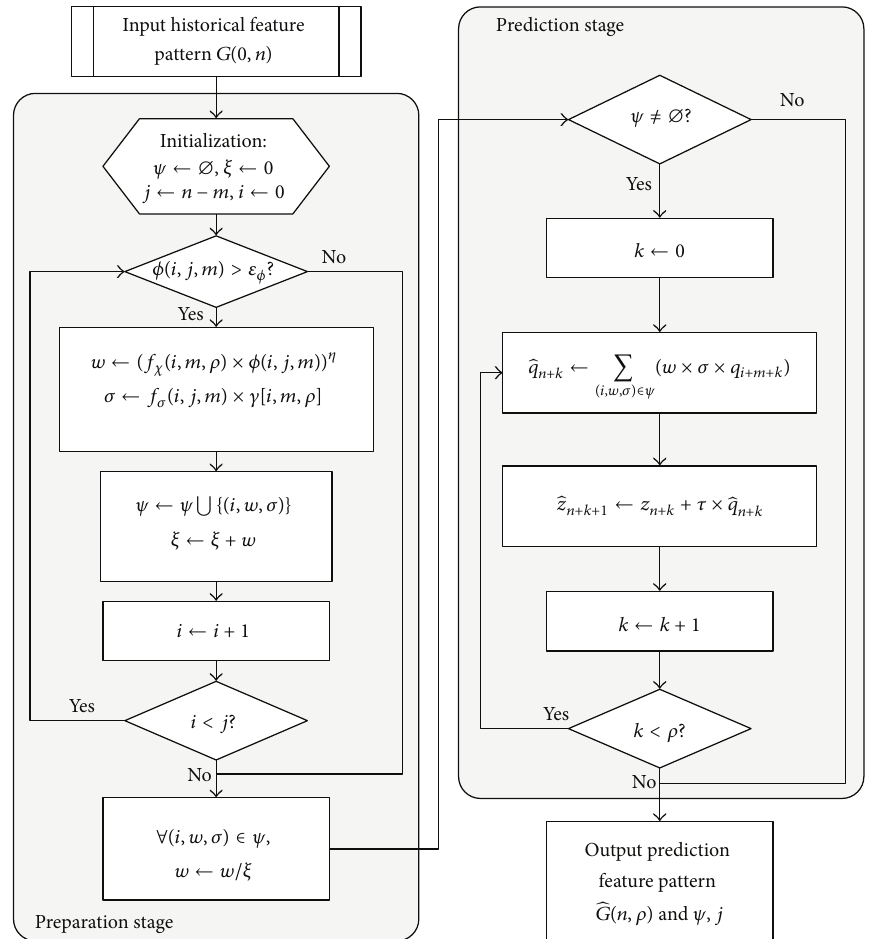
Figure 1: Prediction algorithm flow